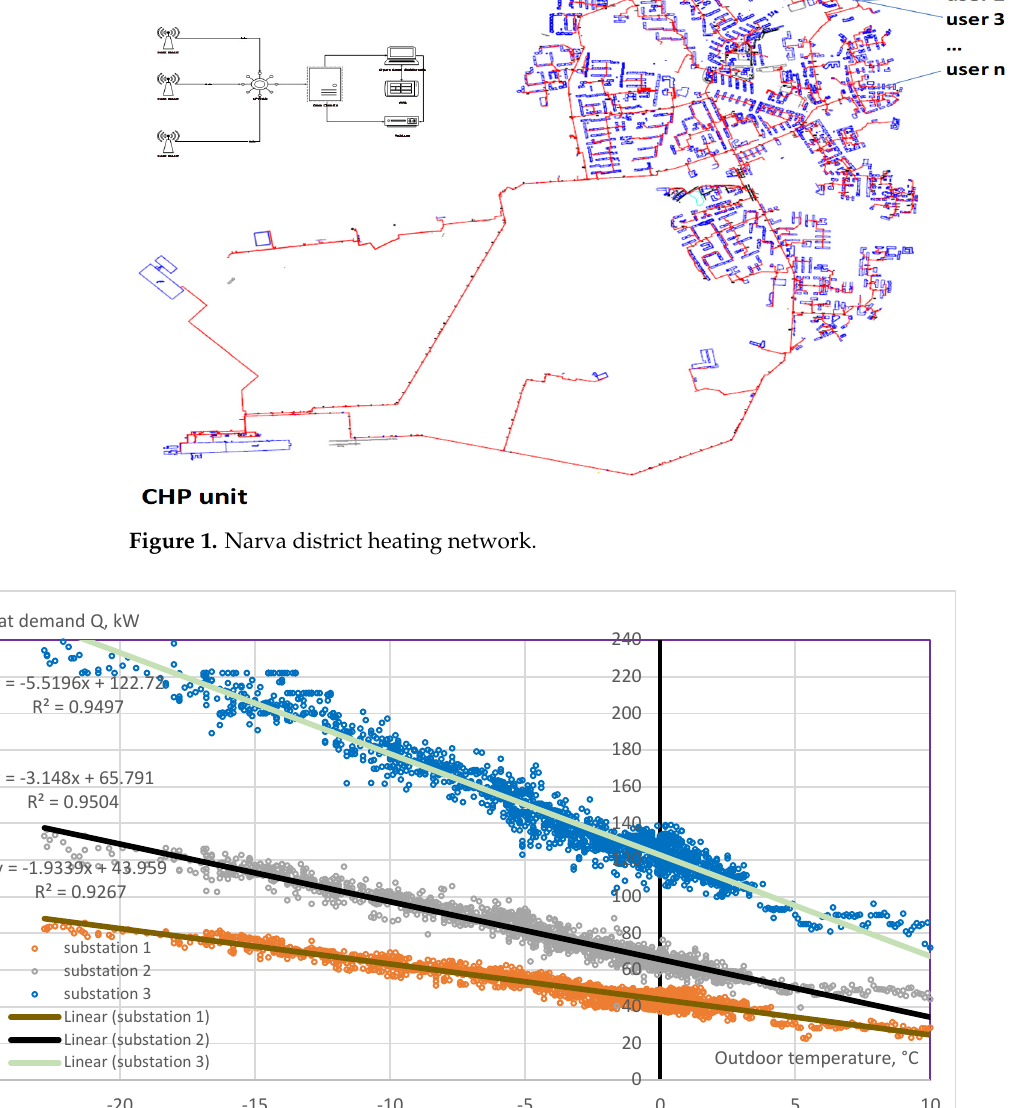
Figure 7. CHP unit electrical load and heat load according Narva city DH network.